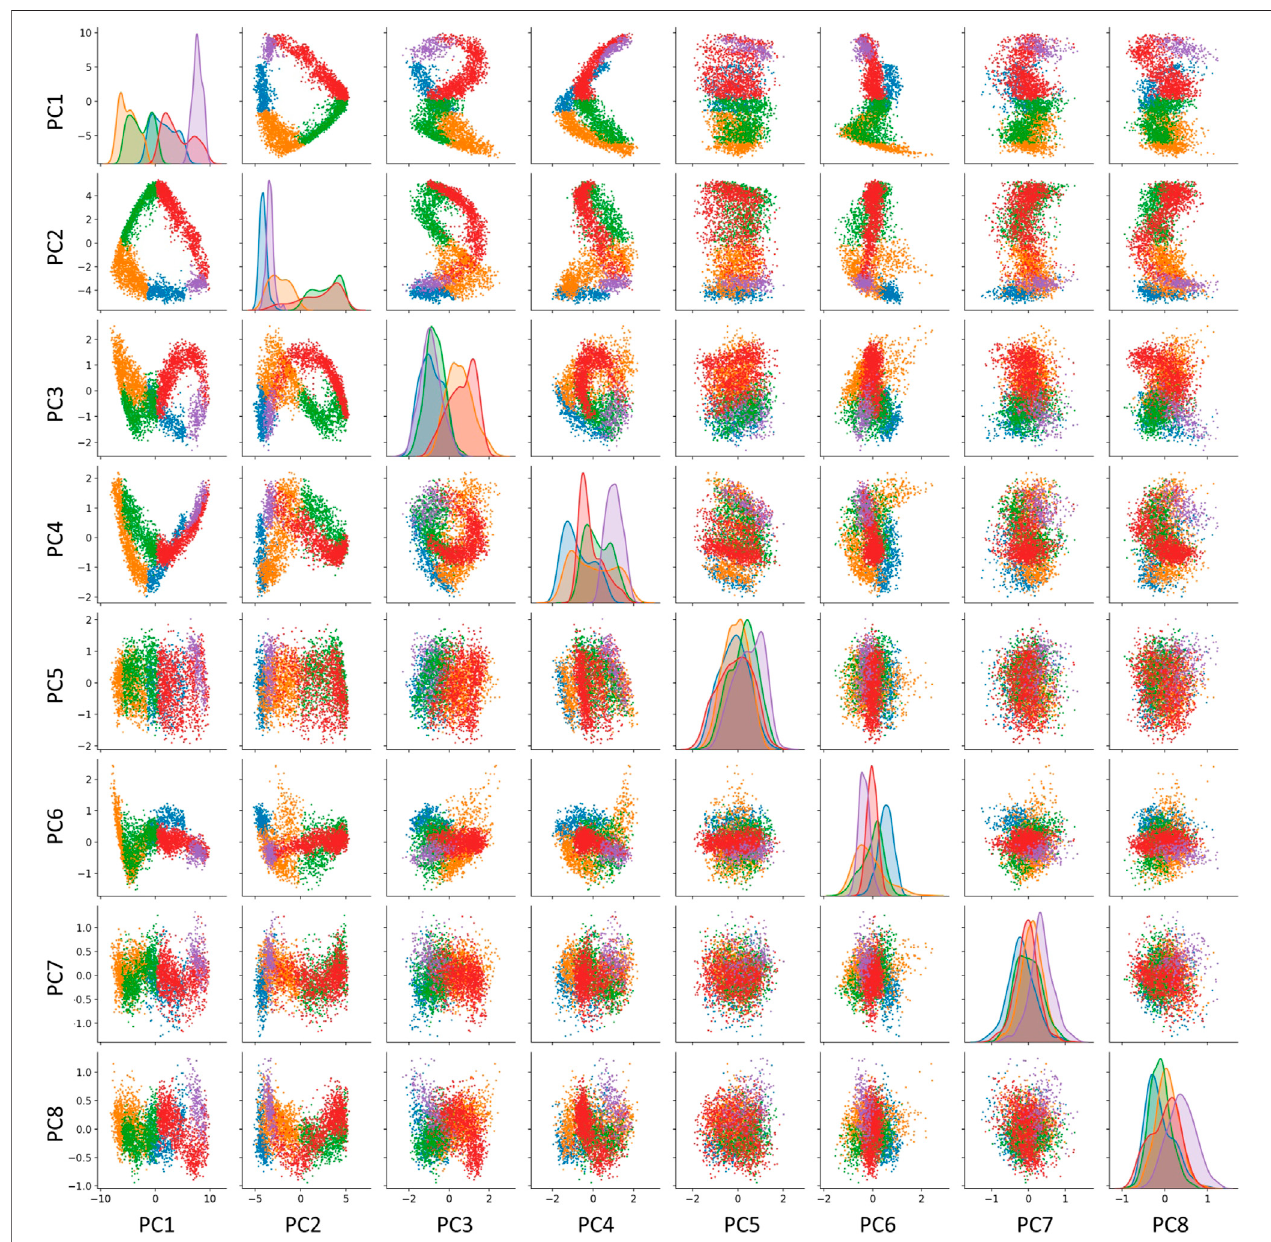
FIGURE5| Visualizing thetranscriptomiccellcycletrajectoryofCHLA9celllineinprojectionsonthe fi rsteightprincipalcomponents,computedinthesubspaceof knowncellcyclegenes.ThedatapointsarepartitionedaccordingtothesegmentationoftheCCTinto fi vetranscriptomicepochs,alsoshownin Figure1 ,0-A(blue),A-B (orange), B-C (green), C-D (red), D-E